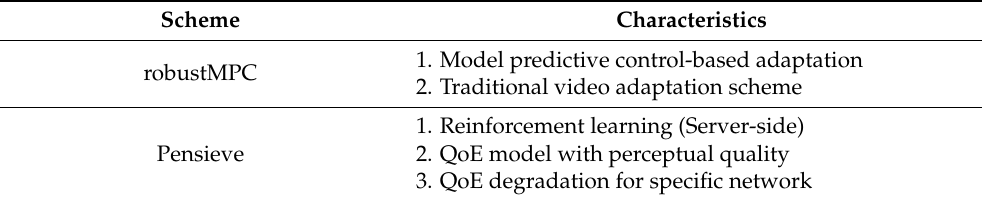
Table 3. Analysis of existing video adaptation schemes for performance evaluation.